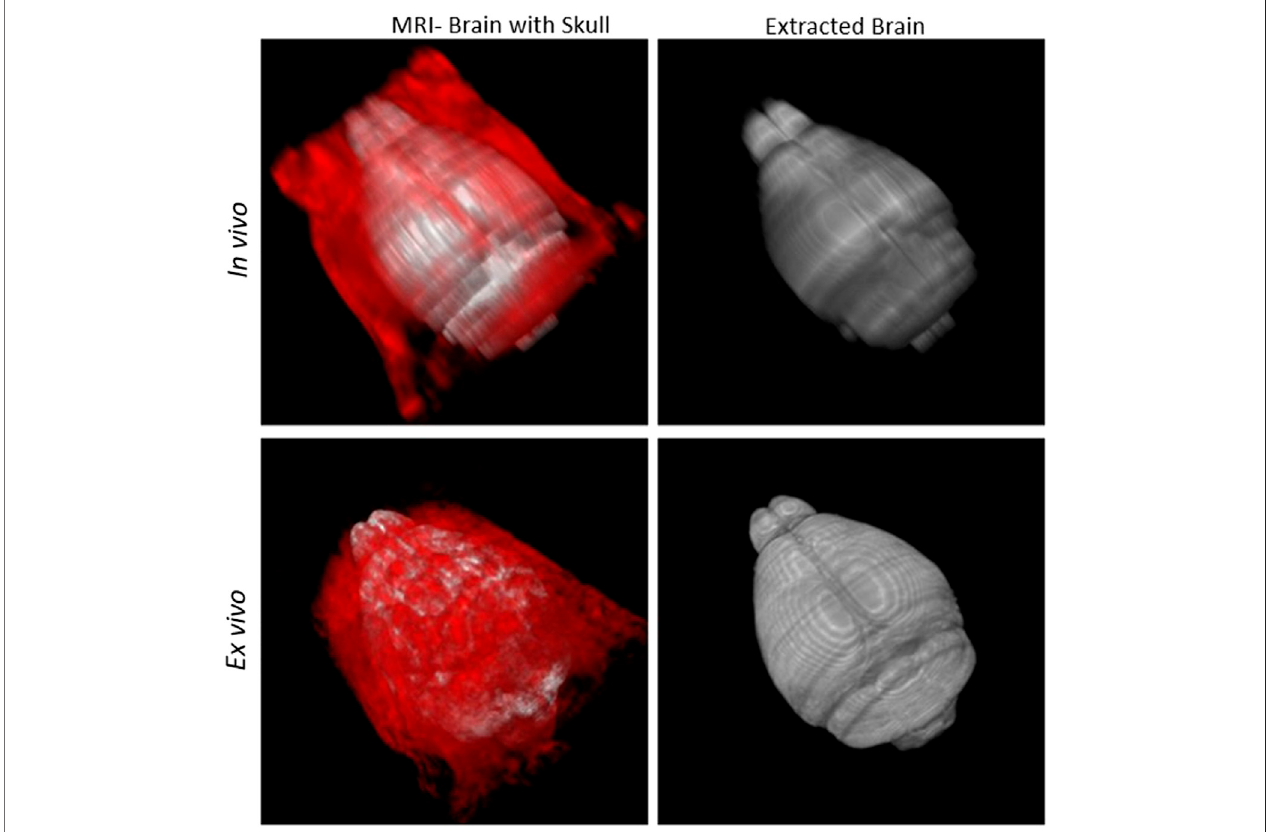
FIGURE 12 | Skull-stripping: First column: Brain (grey) with skull (red). Second column: Segmented brain using